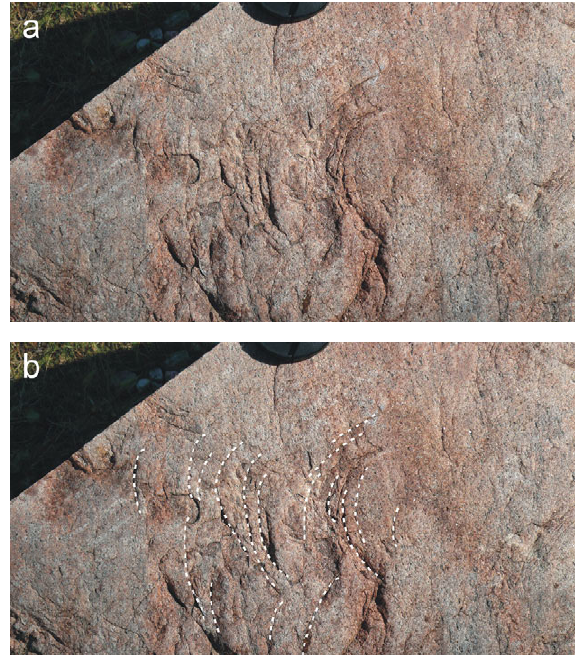
Fig. 7: a – crescentic fractures on the top side of a gneiss (one of three erratic boulders in front of the Sport School Complex); b – marked crescentic fractures.